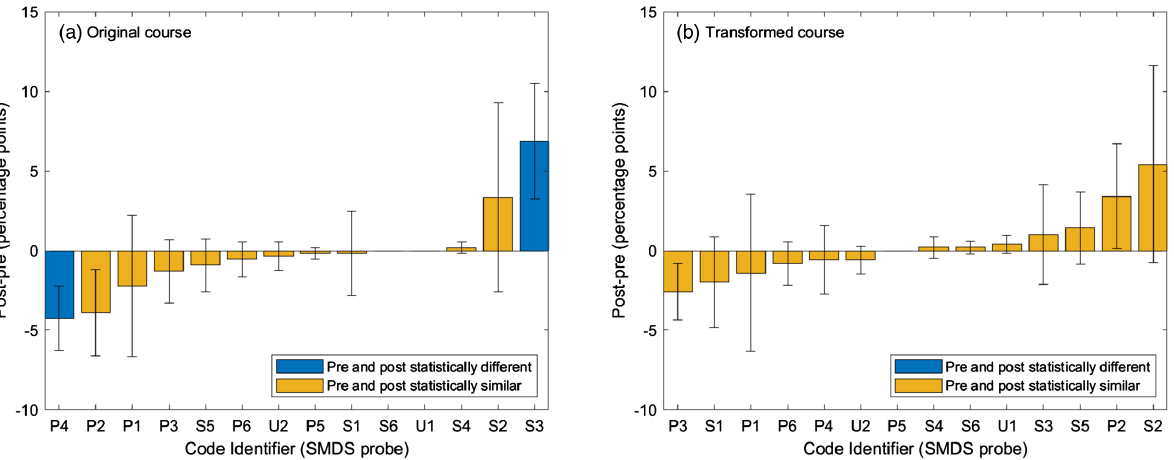
FIG. 6. Pre-post differences in code counts for the SMDS probe, for the original course (a) and the transformed course (b). Blue bars are statistically significant differences using Fisher ’ s exact test at the 95% confidence interval, adjusted using the Holm-Bonferroni method. Orange bars are not significant by that same test. Error bars are the binomial proportion confidence interval at the 95% confidence